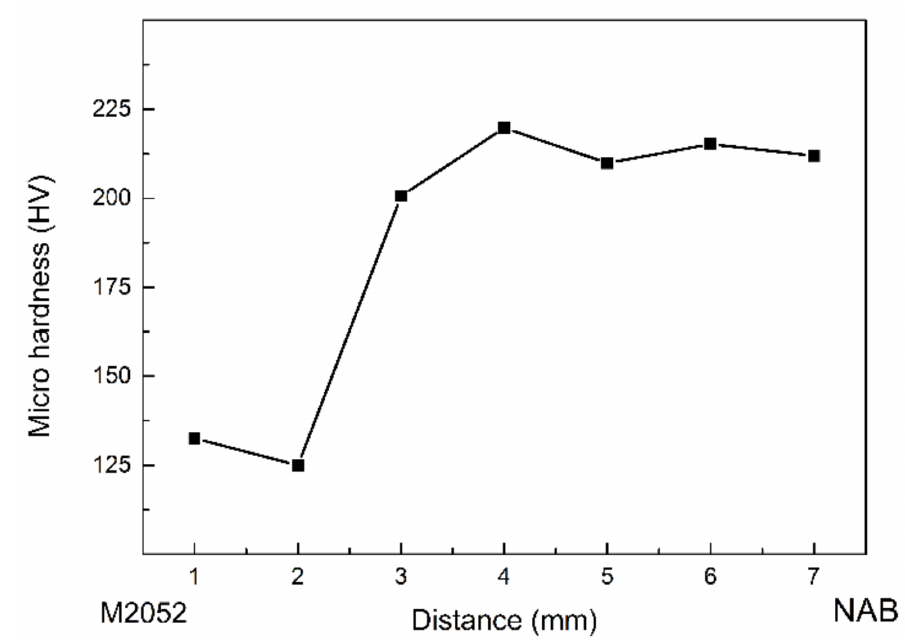
Figure 7. Microhardness of graded material from M2052 to